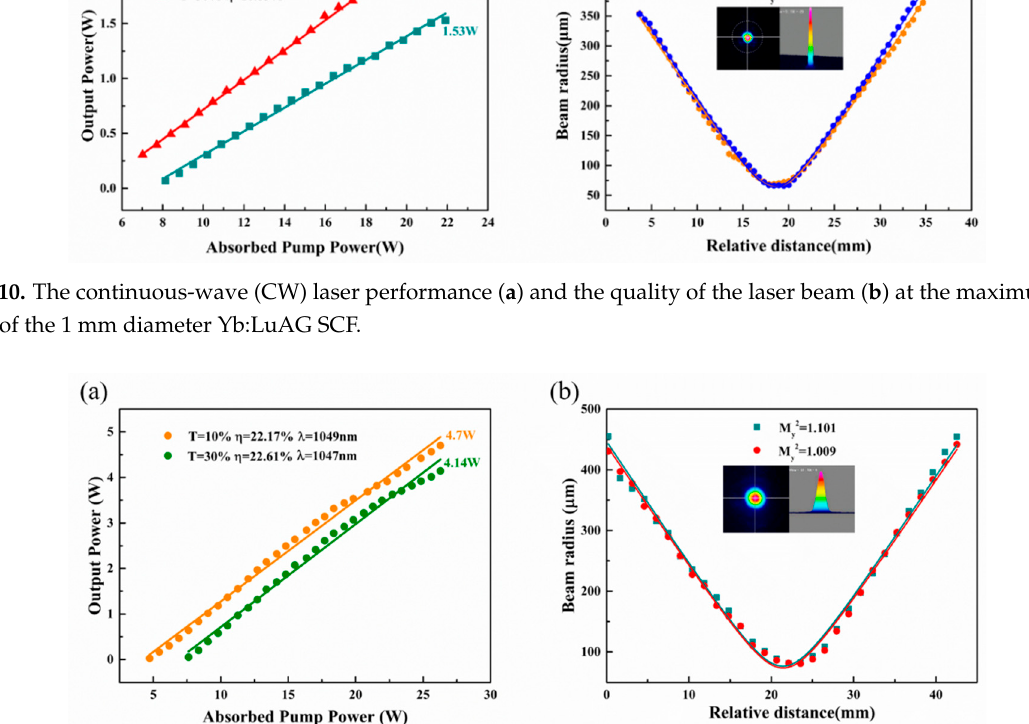
Figure 11. The CW laser performance ( a ) and the quality of the laser beam ( b ) at the maximum power output of the 3 mm diameter Yb:LuAG SCF.